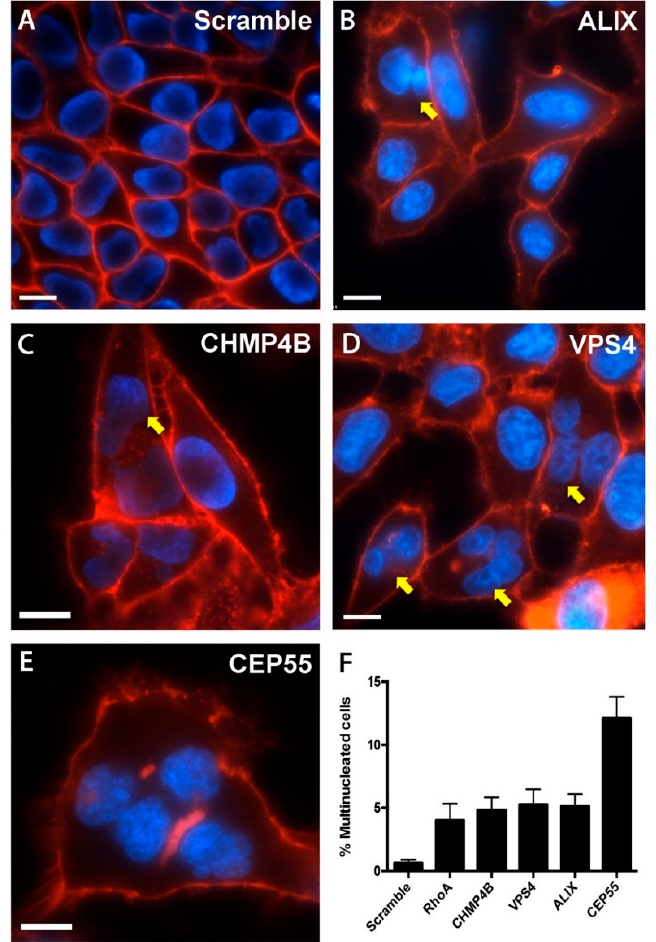
Figure 3. Knockdown of abscission proteins results in multinucleated cells. Representative images of HeLa cells treated with: ( A ) Scramble siRNA, ( B ) ALIX siRNA, ( C ) CHMP4B siRNA. ( D ) VPS4 siRNA, ( E ) CEP55. Following siRNA treatments, cells were fixed, stained, and imaged by fluorescence microscopy at 60X magnification. Yellow arrows depict cells with multiple nuclei. ( F ) Quantitative analysis of cell multinucleation of a minimum of 100 cells per image, across 30 images per treatment, with data displayed as the percentage of cells with two or more nuclei. Plasma membranes were labeled with FM4-64 (red), nuclei were labeled with DAPI (blue). A minimum of 10 image fields were taken for each treatment, n = 3, scale bar = 10 µm.